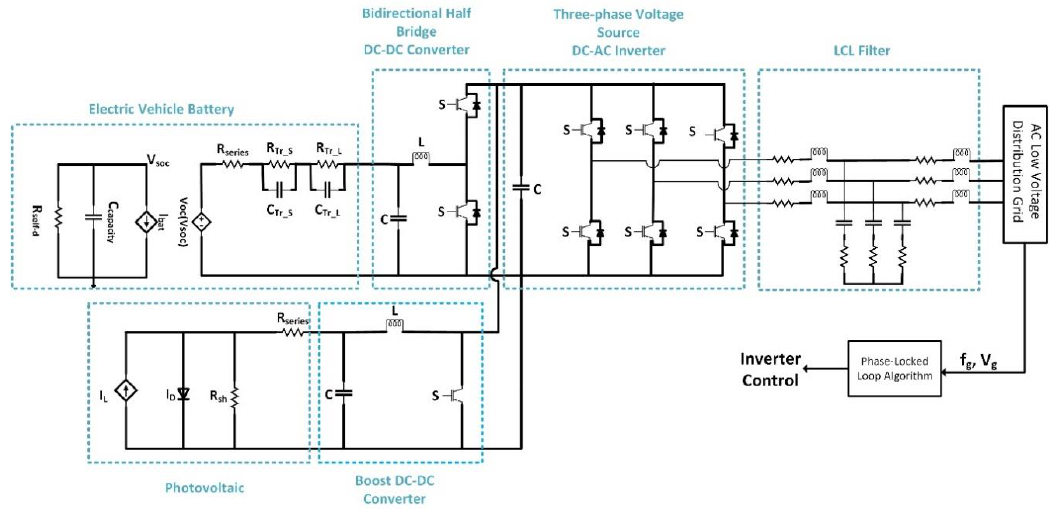
Figure 1. The DC nanogrid configuration. Reprint with permission [29]; 2020, IEEE